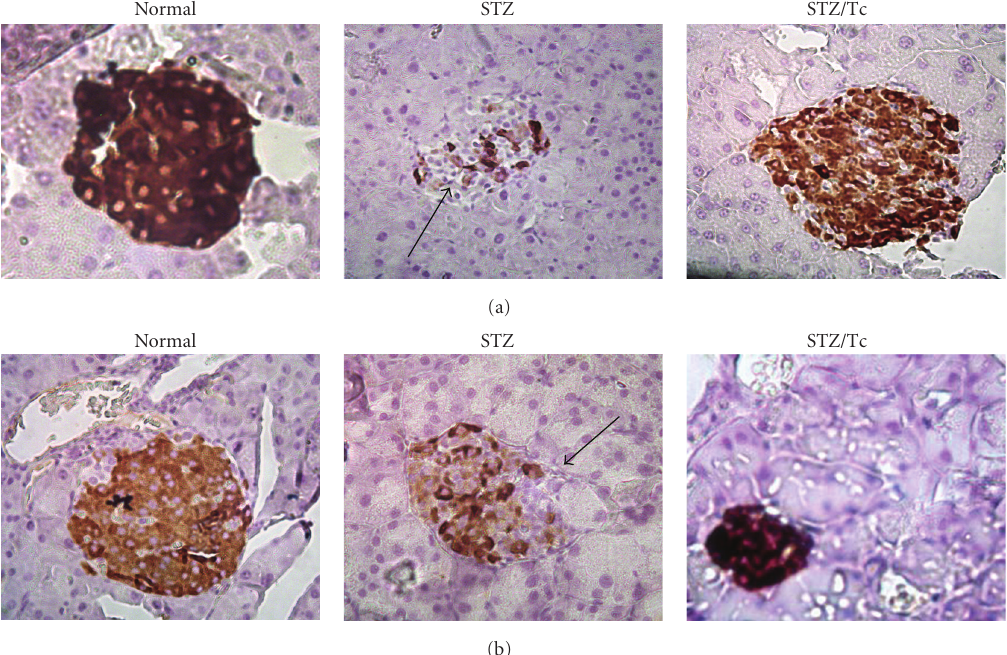
Figure 4: Insulin immunostaining of pancreatic islet cell from MLDS-treated mice. (a) Immunostaining of insulin in islets from BALB/c mice, insulin immunostaining in pancreatic islets of di ff erent uninfected (normal), uninfected and MLDS-treated mice (STZ), or T. crassiceps -infected MLDS-treated mice (STZ/Tc). Mice ( n = 4) were sacrificed 6 weeks after the initial injection of MLDS and pancreata were processed for immunohistochemistry to specifically detect insulin. (b) Same as (a), just the sections belong to C57BL/6 mice. Note the lack of insulin staining in uninfected MLDS-treated mice. Magnification ×